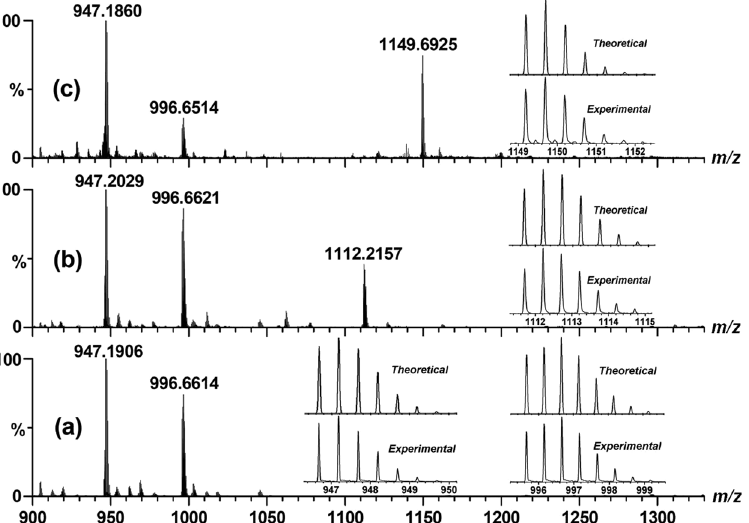
Figure 2. ESI-MS of ( a ) Co– ZPB (0.1 mM) and ( b ) Co– ZPB (0.1 mM) after the addition of 1 equiv. of Fl in CH 3 CN solution. ESI-MS of ( c ) Co– ZPB (0.1 mM) after the addition of 1 equiv. of ATP in CH 3 CN/H 2 O solution. Insets show the measured and simulated isotopic patterns at 947.19, 996.66 ( a ), 1112.22 ( b ) and 1149.69 ( c